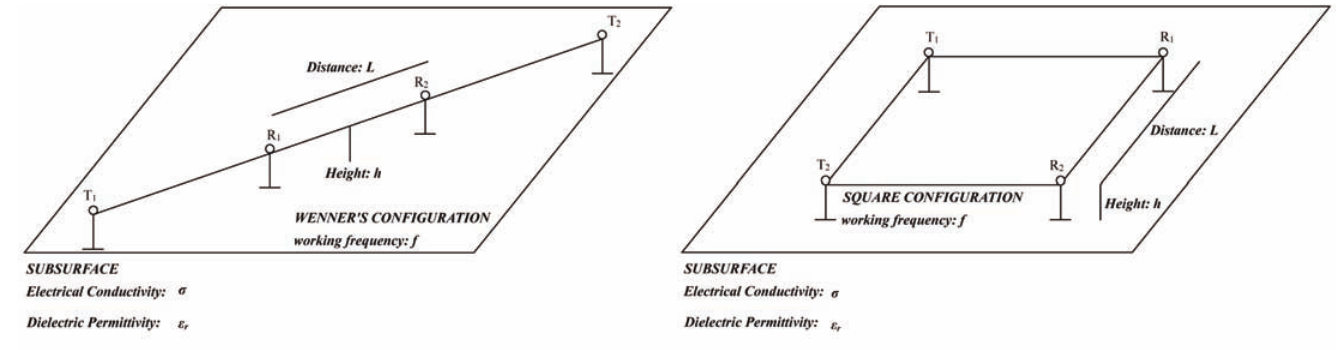
Figure 2a. Quadrupole probe in the linear Wenner configuration. Figure 2b. Quadrupole probe in the square